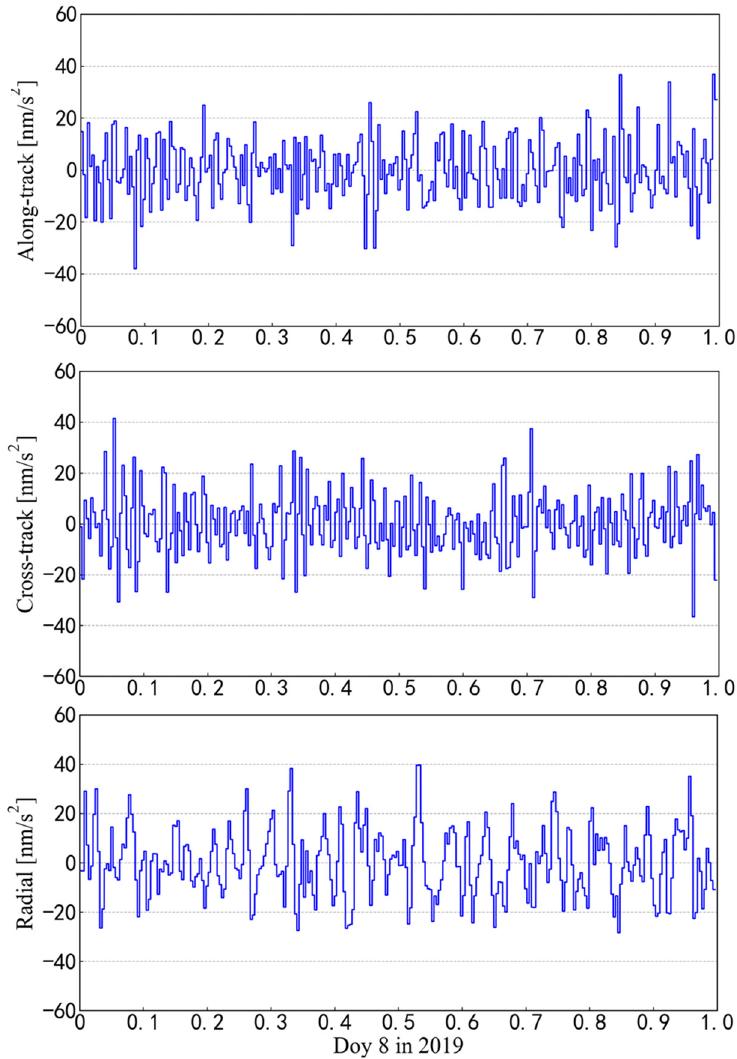
Figure 1. Piecewise constant accelerations of the reduced-dynamic orbit determination on 8 January 2019 (day of year DOY 8). These accelerations are described as constant values in the along-track ( top ), cross-track ( middle ), and radial ( bottom ) directions at consecutive intervals of 5 min. As a starting point, estimated constant accelerations as well as reduced dynamic orbit solutions were obtained for a 14-day period, in which the acceleration value was used for spectral analysis. A power spectrum analysis of the residual accelerations in three directions is shown in Figure 2. The along-track direction and orbital radial direction show a clear periodic signal, while the results of the cross-track direction are complicated. For the along-track direction, 4 CPR is the dominant periodic signal. There is a noticeable signal of 2 CPR in the radial direction. However, a mixed spectrum is observed in the cross-track direction, and it is hard to identify the periodicity of the acceleration.